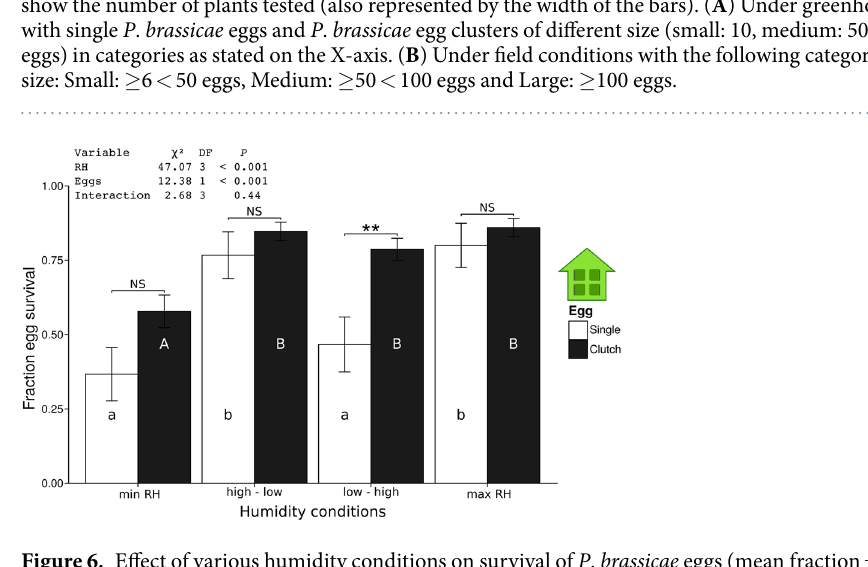
Figure 6. Effect of various humidity conditions on survival of P . brassicae eggs (mean fraction ± SE) until larval hatching. For the water/humidity treatment: compare Fig. S8. Different lowercase letters indicate significant differences in survival ( P < 0.05, LHT post hoc test) of single eggs kept at different humidity conditions, while capital letters indicate significant differences in survival rates ( P < 0.05, LHT post hoc test) of five eggs (clutch) kept at different humidity conditions. Asterisks above bars indicate whether or not survival rates of eggs differ between single and clustered eggs kept at a particular humidity treatment (LHT post hoc test). NS = Not significant, ** P < 0.01, GLM. N per treatment =